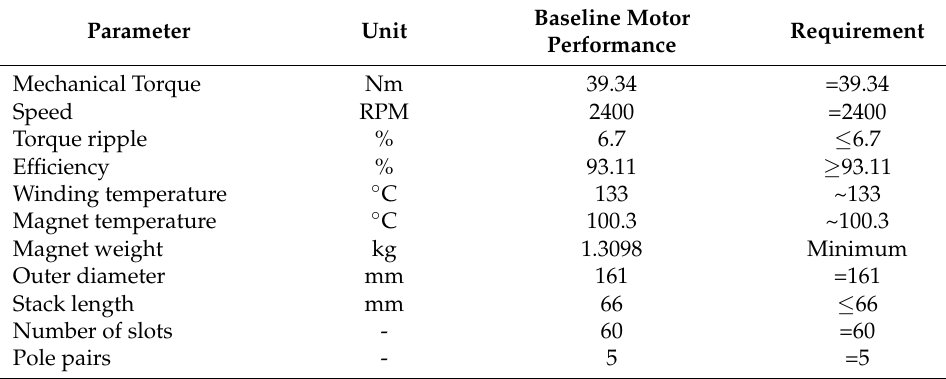
Table 3. Baseline motor performance and new design